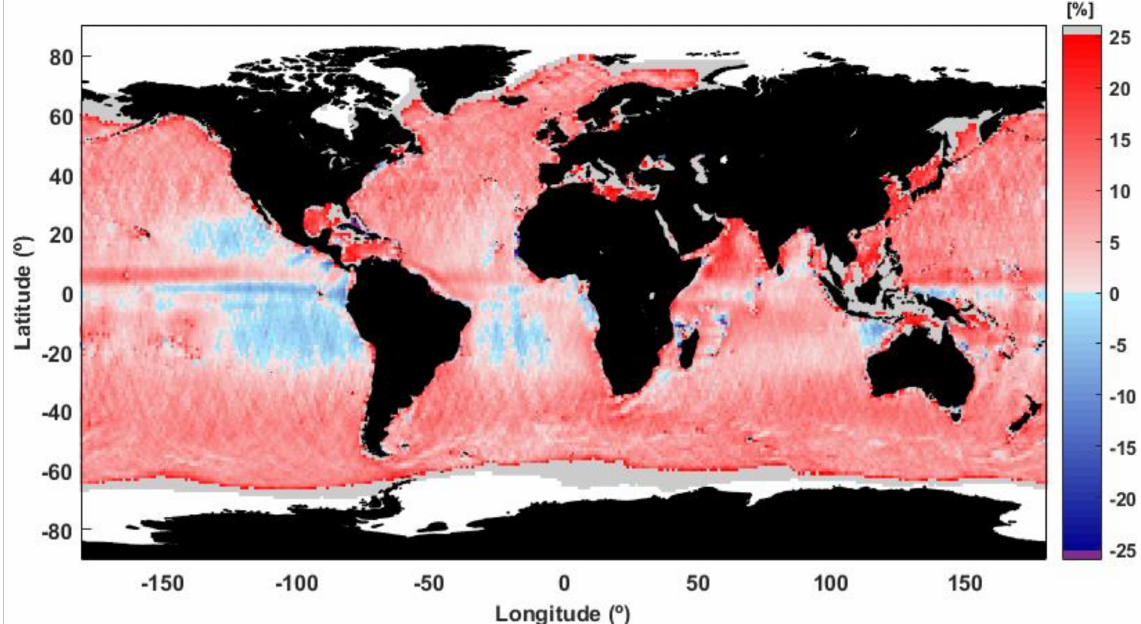
Figure 9. Normalized differences (%) between climatological means of E w-CCI and E w-ERA5 over the 27-year time interval (1992–2018).